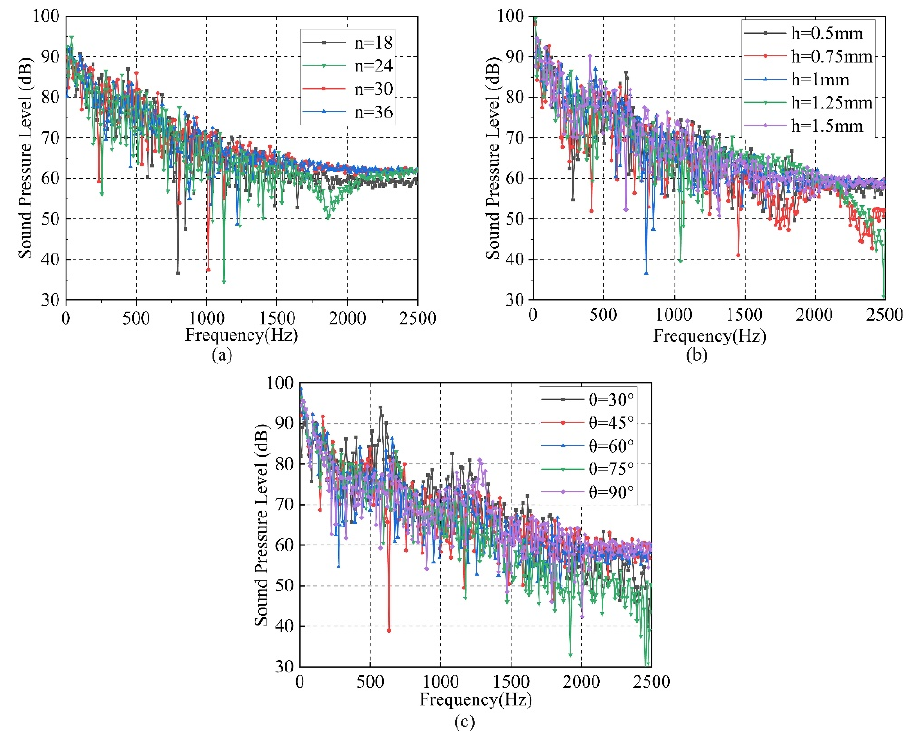
Figure 8. Effect of dimension parameters on sound pressure level of bionic tailpipes: ( a ) circumferential column number n, ( b ) texture height h, ( c ) top angle θ .